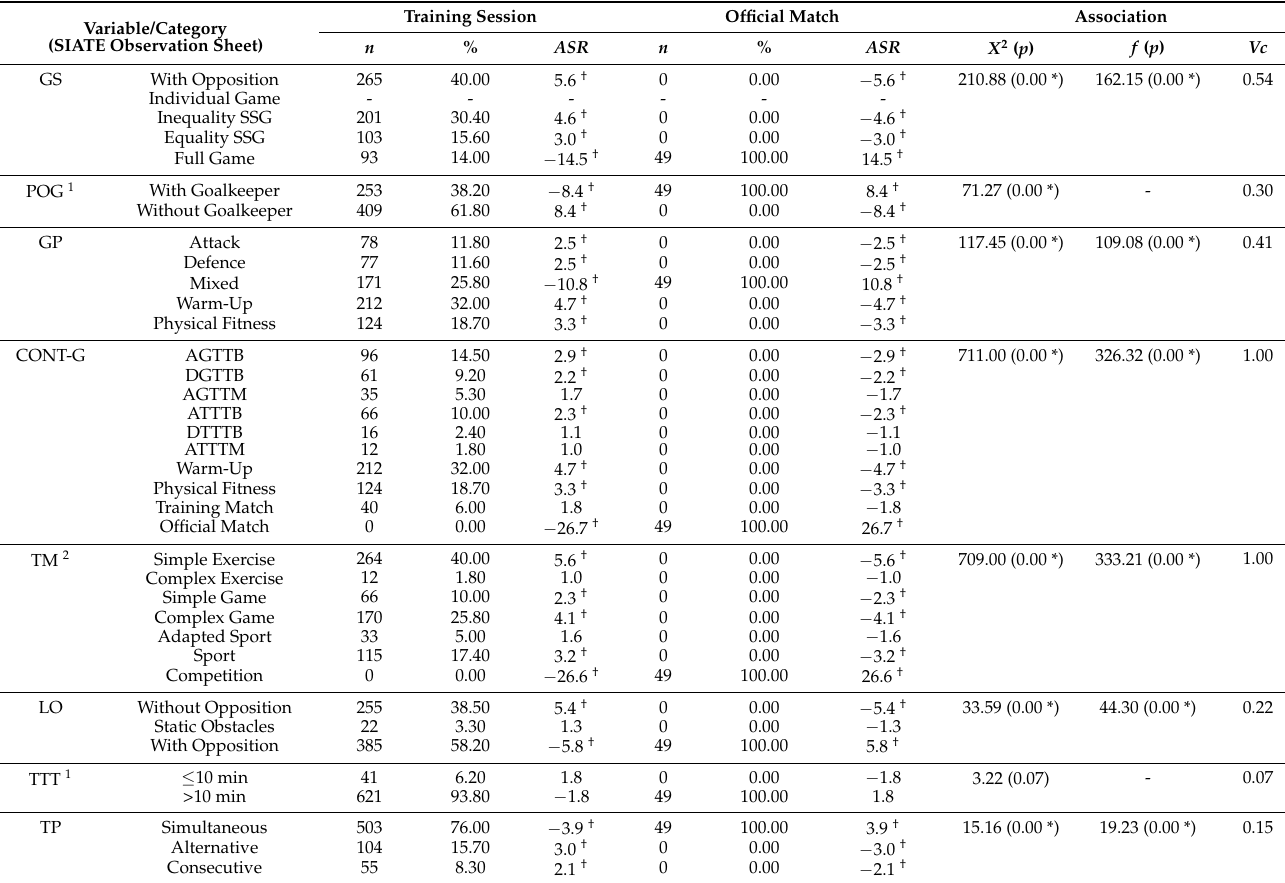
Table 3. Percentages, ASR and association of the pedagogical and organizational